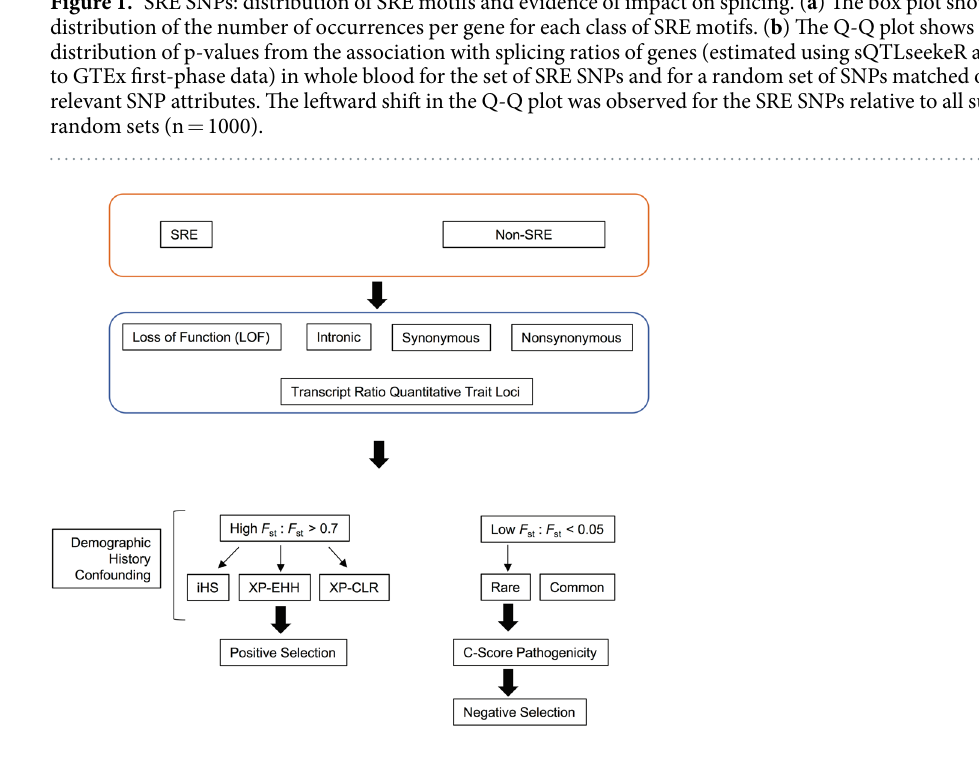
different SNP classes, showing differences between SNP classes in the proportion of low F ST variants. LOF and non-synonymous SRE SNPs have a higher proportion of low F ST variants than intronic and synonymous SRE SNPs (Supplementary Figure 2 for the ASN-EUR comparison and the AFR- ASN comparison, which shows a sim- ilar pattern). While enrichment for low F ST has been previously reported for non-synonymous SNPs (and recapit- ulated here), we observed a substantially greater level of excess (i.e., more than two-fold in terms of percentage) of low population differentiation among the amino-acid altering SRE variants than among all amino-acid altering SNPs 39 . Furthermore, among the LOF and non-synonymous SRE SNPs with low F ST , we observed an excess of low